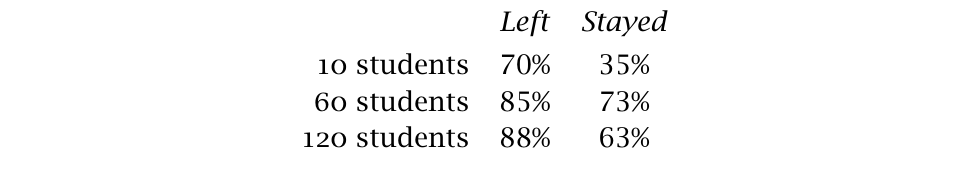
Table 8 Percentages of positive answers by question and cardinality for questions ( 1 ) and ( 2 )